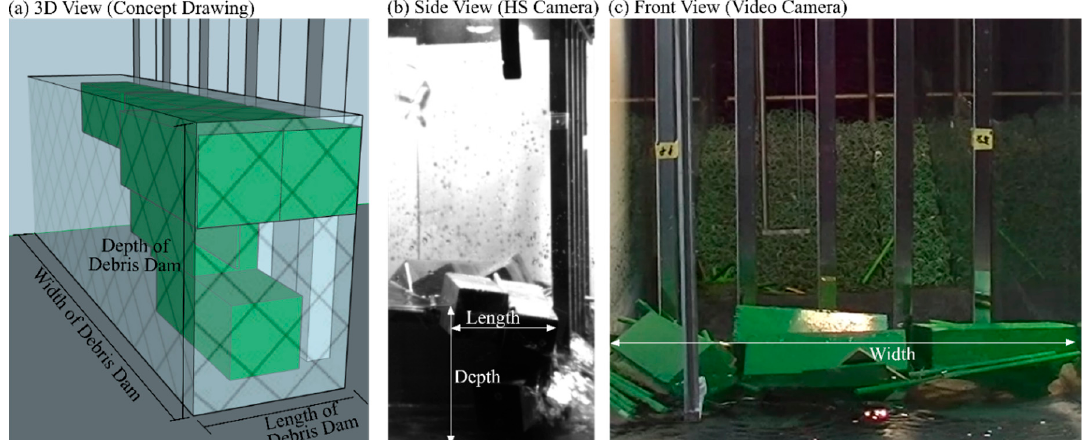
Figure 5. Measurement of debris dam dimensions using a two-camera system: ( a ) conceptual drawing of the dam dimensions; ( b ) image from the HS Camera; and ( c ) image from the video camera. The dimensions of the dam were manually selected for each image within the experiment.